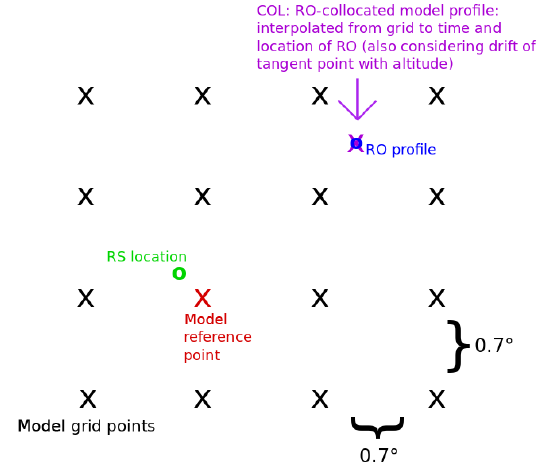
Figure 3. Schematic of the sampling correction applied to RO and RS